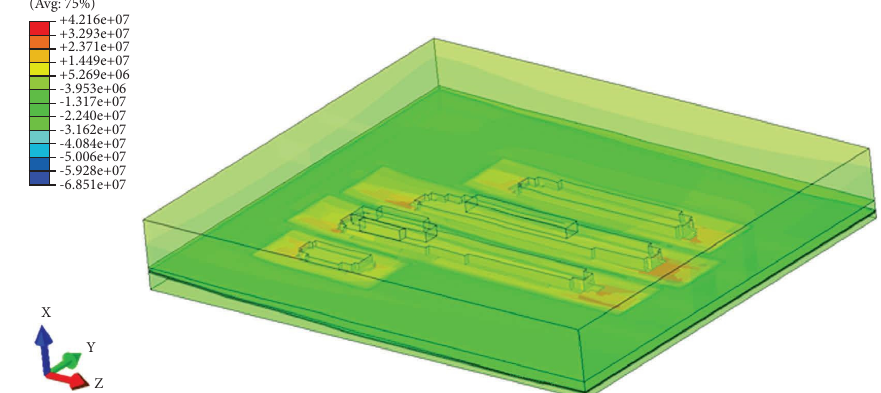
Figure 5: Maximum principal stress distribution in No.6 mining